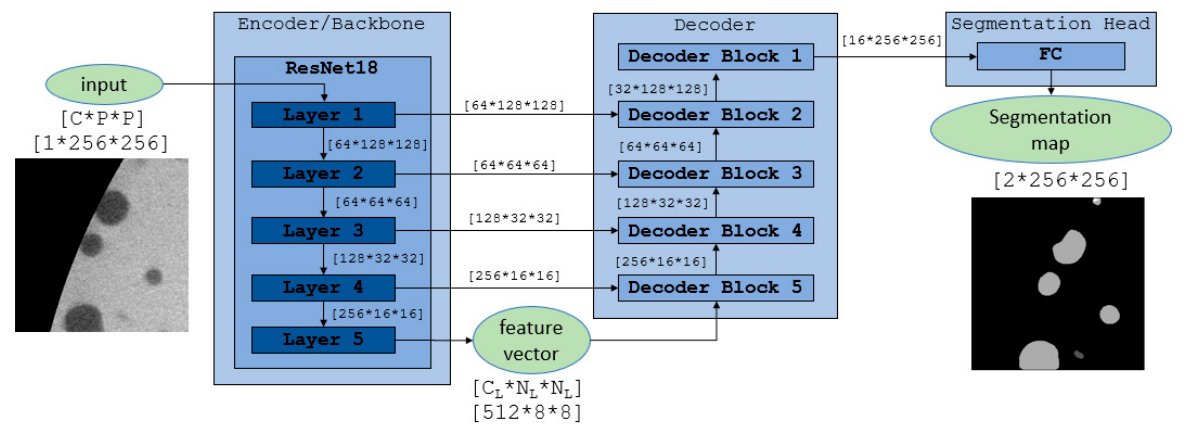
Figure 4. U-Net architecture with ResNet18 backbone and standard U-Net decoder. The encoder follows the exact same architecture of ResNet18 available in [49]. The dimensions at each resolution are calculated based on a grayscale 256 × 256 patch of the original image.